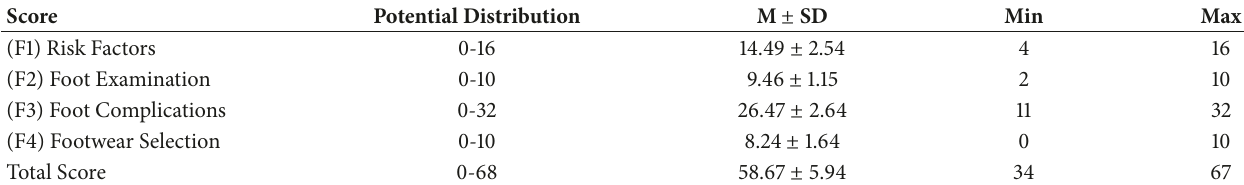
Table 3: Distribution of nurses’ knowledge level form scores related to diabetic foot management.